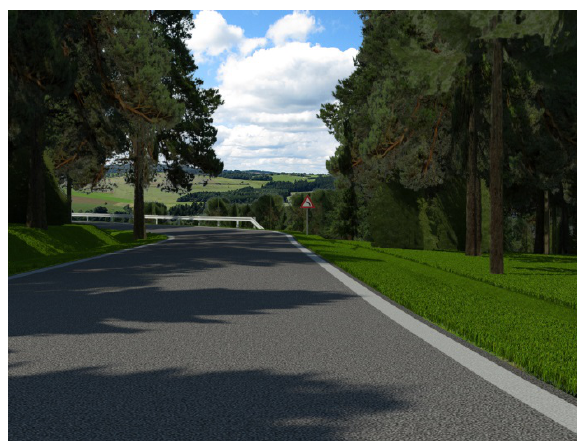
Figure 12. Final simulation